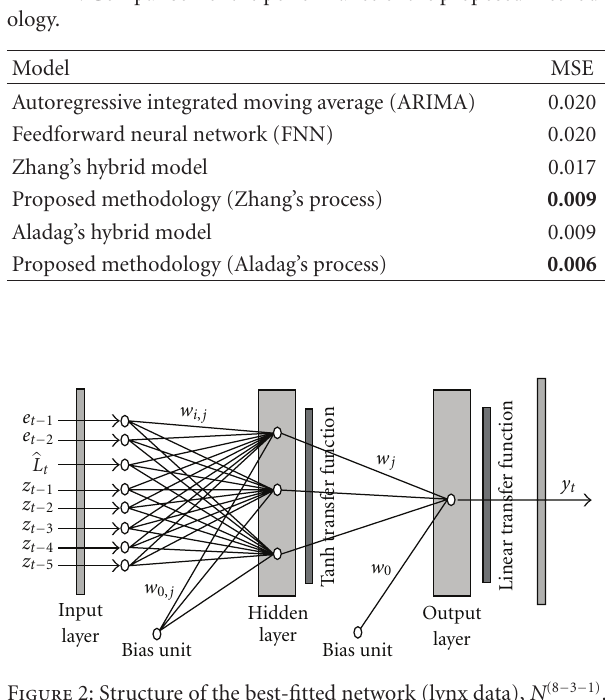
Figure 2: Structure of the best-fitted network (lynx data), N (8 − 3 − 1) .